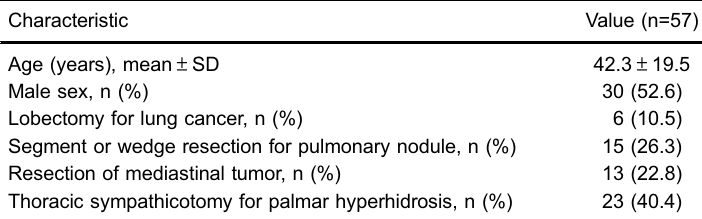
Table 1. Characteristics of the